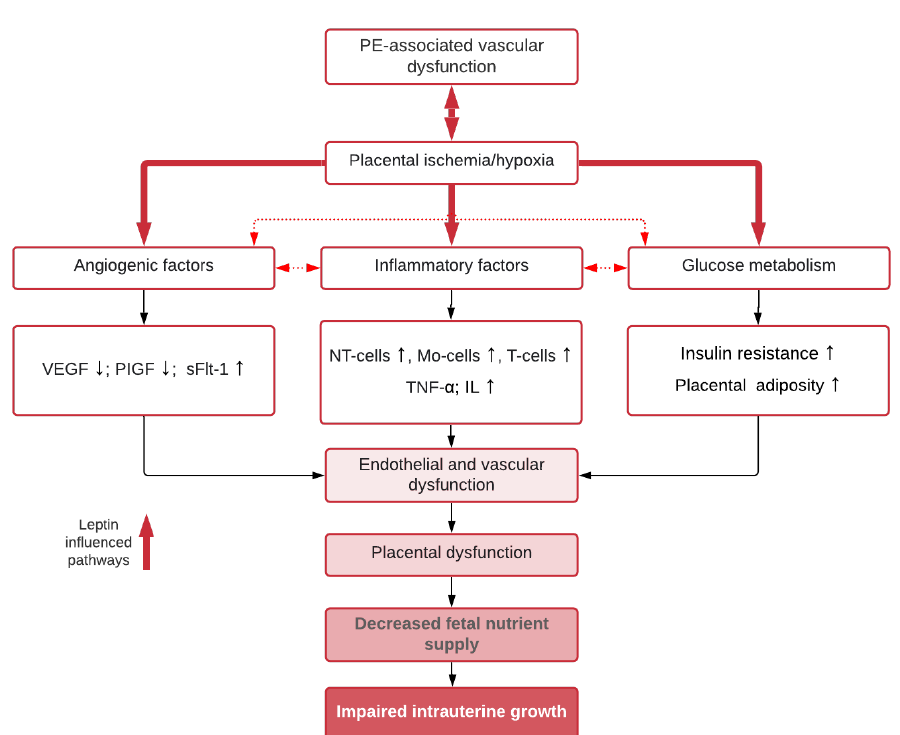
Figure 2. Key leptin-regulated pathways in impaired intrauterine growth in pre-eclampsia. Abbreviations: VEGF: Vascular Endothelial Growth Factor; PIGF: Placental Growth Factor; sFlt1: Soluble Fms-like Tyrosine Kinase-1; NT-cells: Neutrocytes; Mo-cells: Monocytes; TNF-α: Tumor Necrosis Factor alpha; IL: Interleukins.